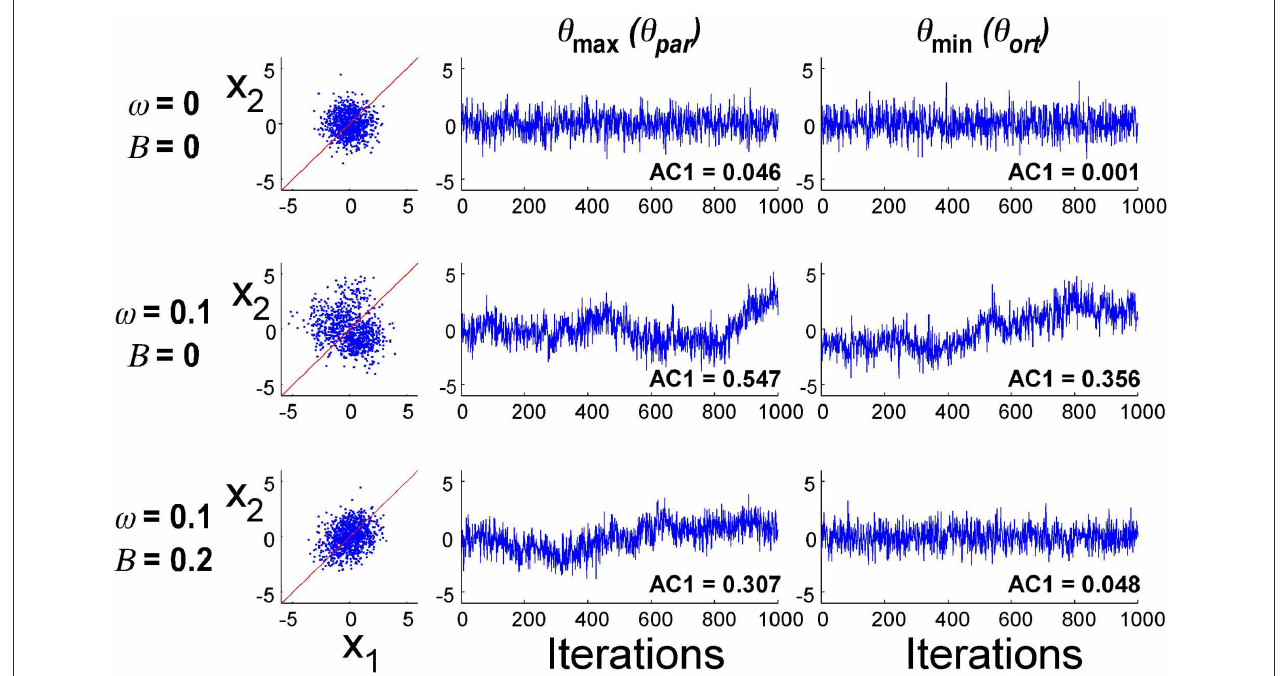
FIGURE 8 | Exemplary simulation results for three different parameter combinations (1000 iterations). Distribution of data in execution space and time series of error in two directions in execution